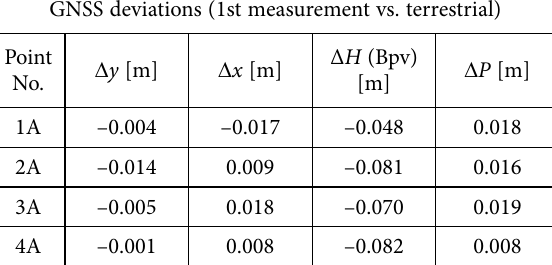
Table 3. Comparison of results (GNSS vs. terrestrial) –